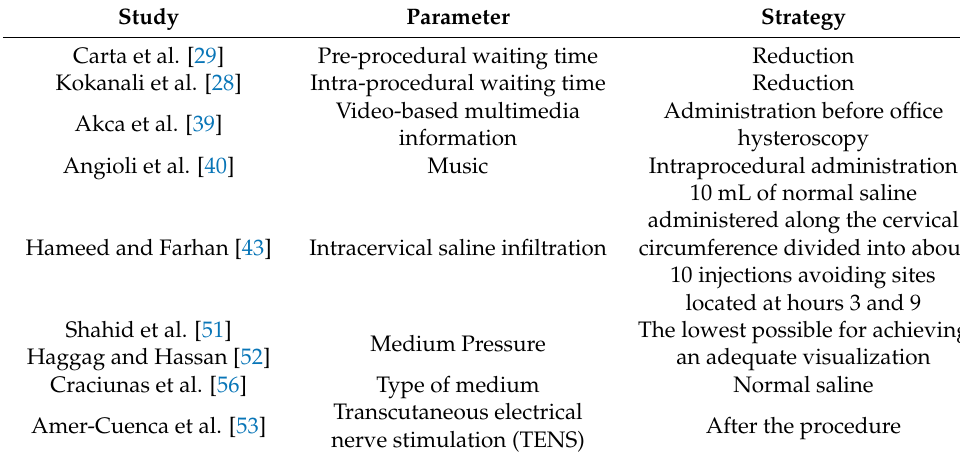
Table 2. Non-pharmacological strategies for pain relief in office hysteroscopy setting.